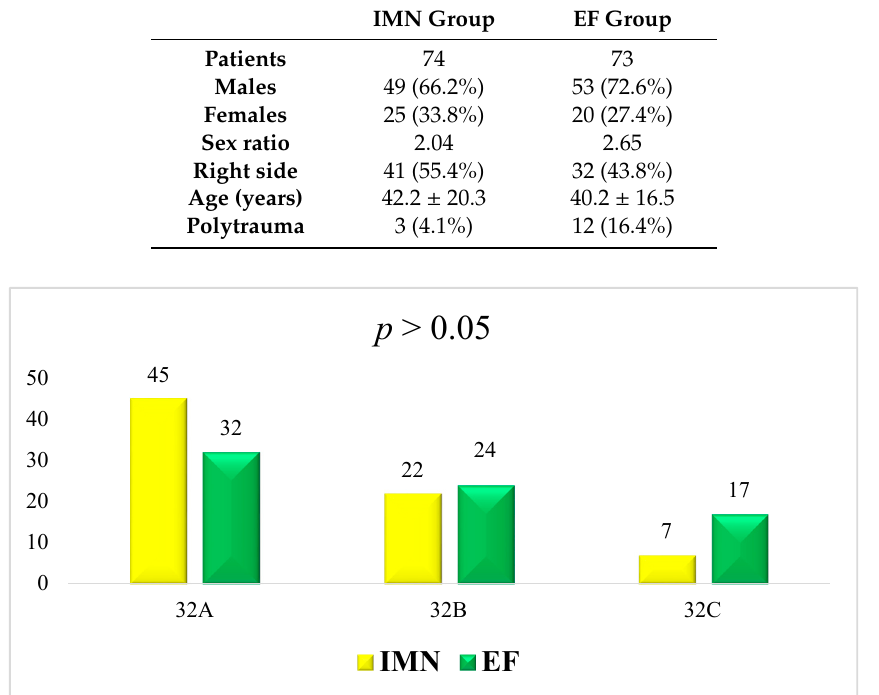
Figure 1. AO classification of IMN and EF groups. Both groups have no statistical differences ( p > 0.05) in sex, laterality, age, and AO classification types.